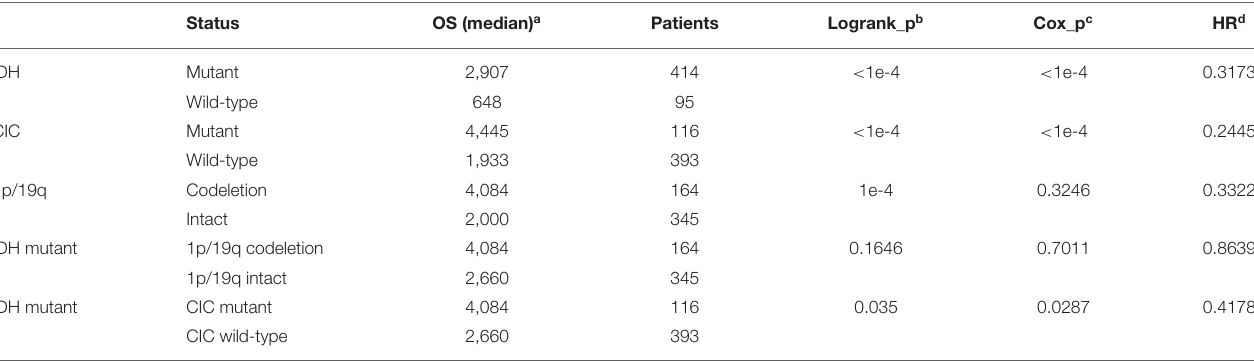
TABLE 2 | Survival analysis